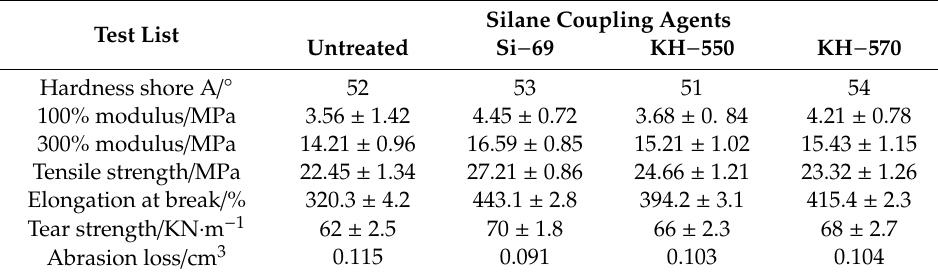
Table 4. E ff ect of di ff erent silane coupling agents on the properties of